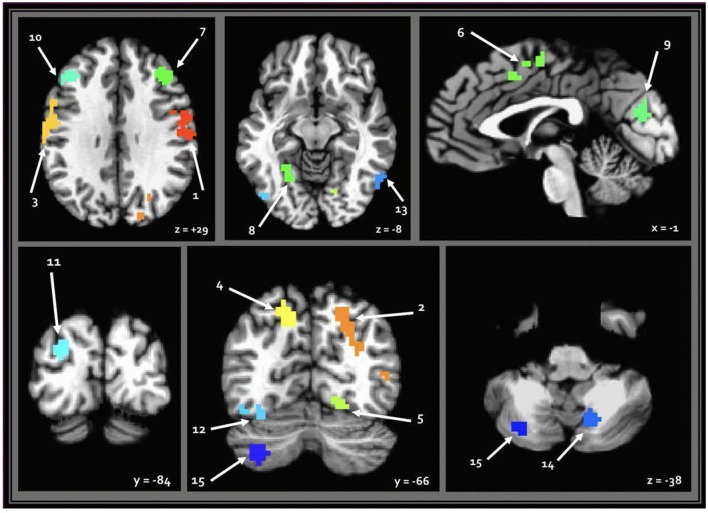
Regions resulting from seed-based analysis showing diagnosis-by-sex interaction. Cerebellar seeds are pictured in the lower right panel. Left is shown on the left, and results are in standard Talairach-Tournoux space. Refer to Table 2 for key of numeric region labels.